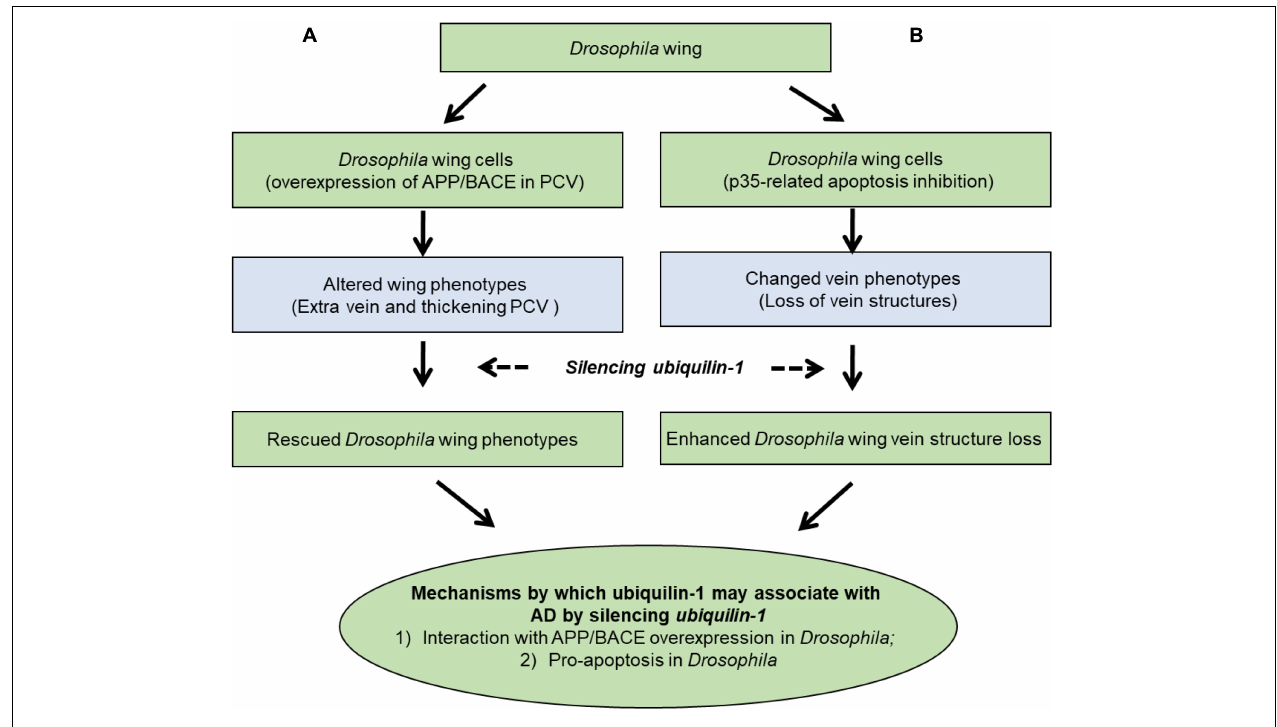
FIGURE 6 | A working model showing mechanisms by which ubiquilin-1 may associate with AD. We characterized the mechanisms by which ubiquilin-1 may associate with AD using Drosophila and cell-based models. Our results extended previous reports and suggested two main mechanisms: (A) an APP/BACE-related (amyloid-dependent) mechanism, in which APP and BACE overexpression-related altered cell number and tissue compartment size in the Drosophila wing posterior crossvein (PCV) is observed and can be rescued by ubqn RNAi (left column). (B) An apoptosis-related (amyloid-independent) mechanism, in which expression of the baculovirus pan-caspase inhibitor p35 in the Drosophila wing resulted in weak loss of vein structures and can be enhanced by ubqn RNAi (right